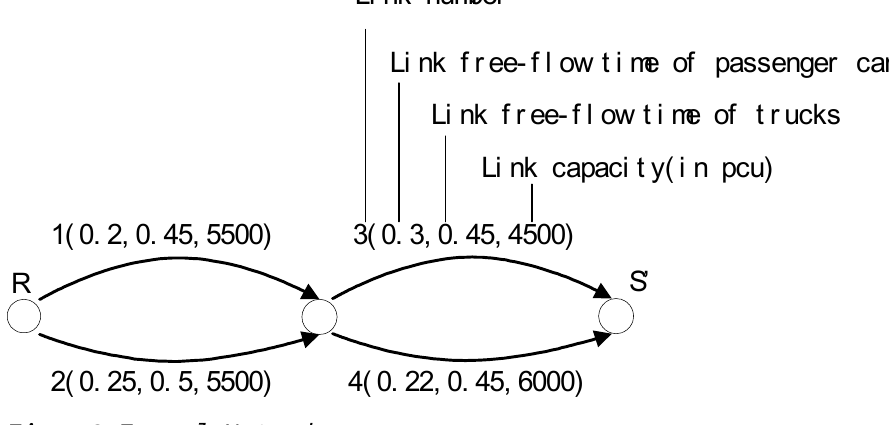
Figure 3. Example